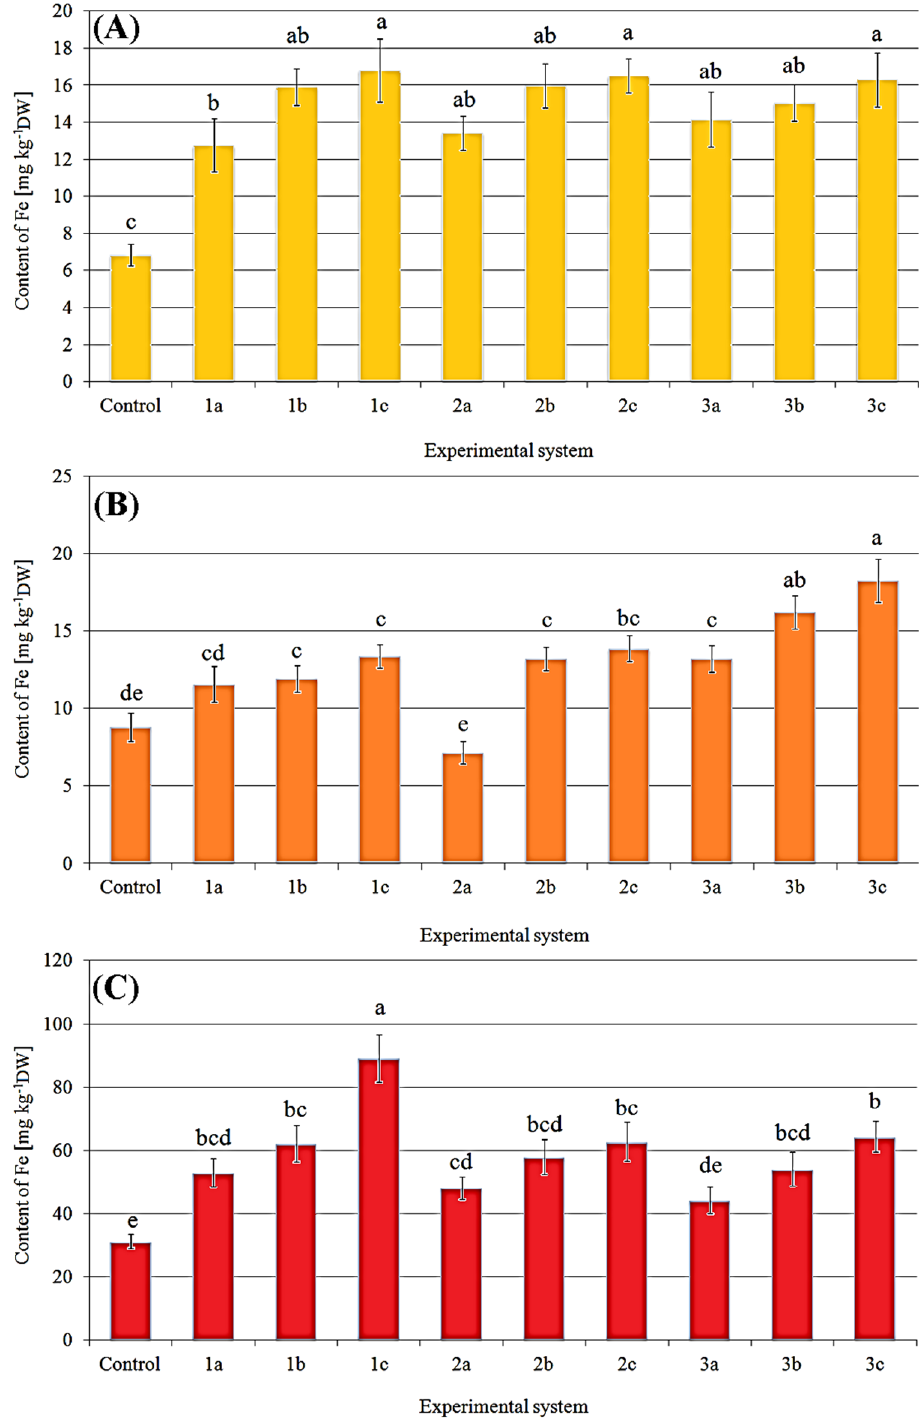
Figure 3. Content of Fe (mg kg -1 DW) in P. eryngii ( A ), P. ostreatus ( B ), and P. nameko ( C ) in the first crop exposed to particular experimental systems. n = 3, identical lower cases ( a , b …) denote non- significant differences between mean content of Fe in fruit bodies growing in particular experimental systems according to post-hoc Tukey’s HSD test.